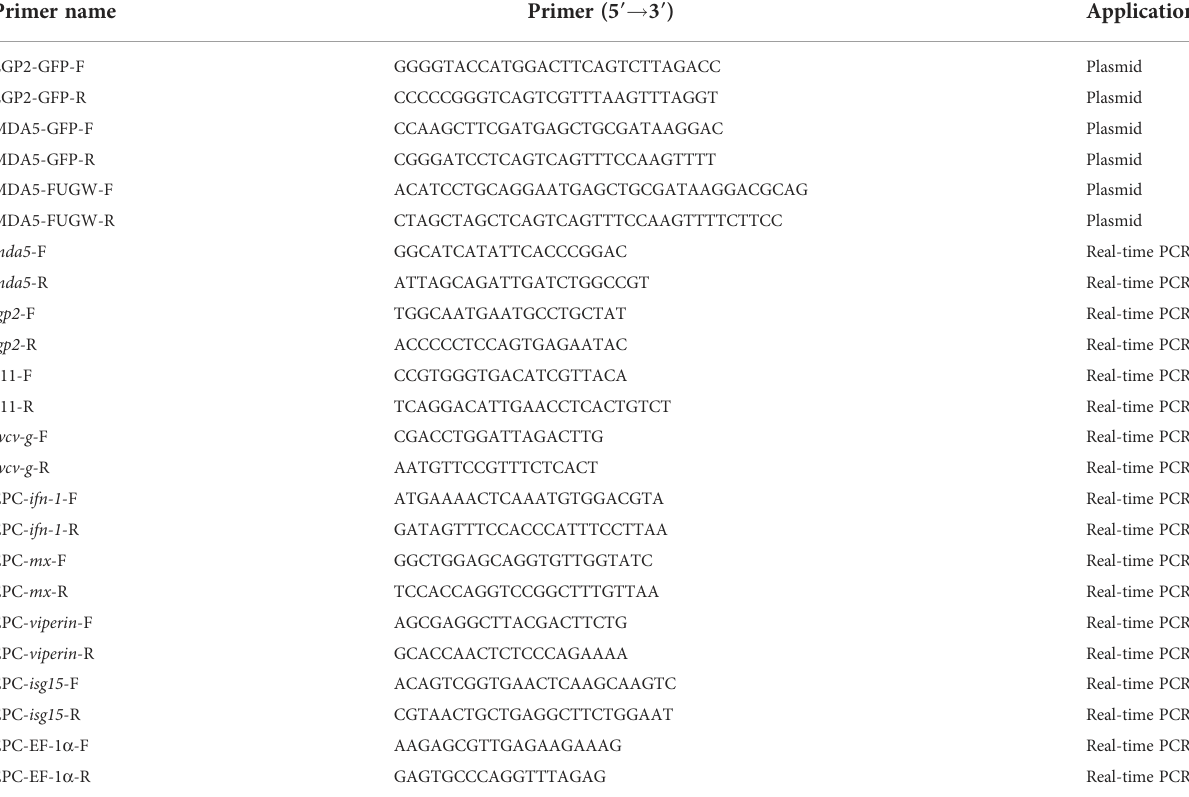
TABLE 1 Primers used in this